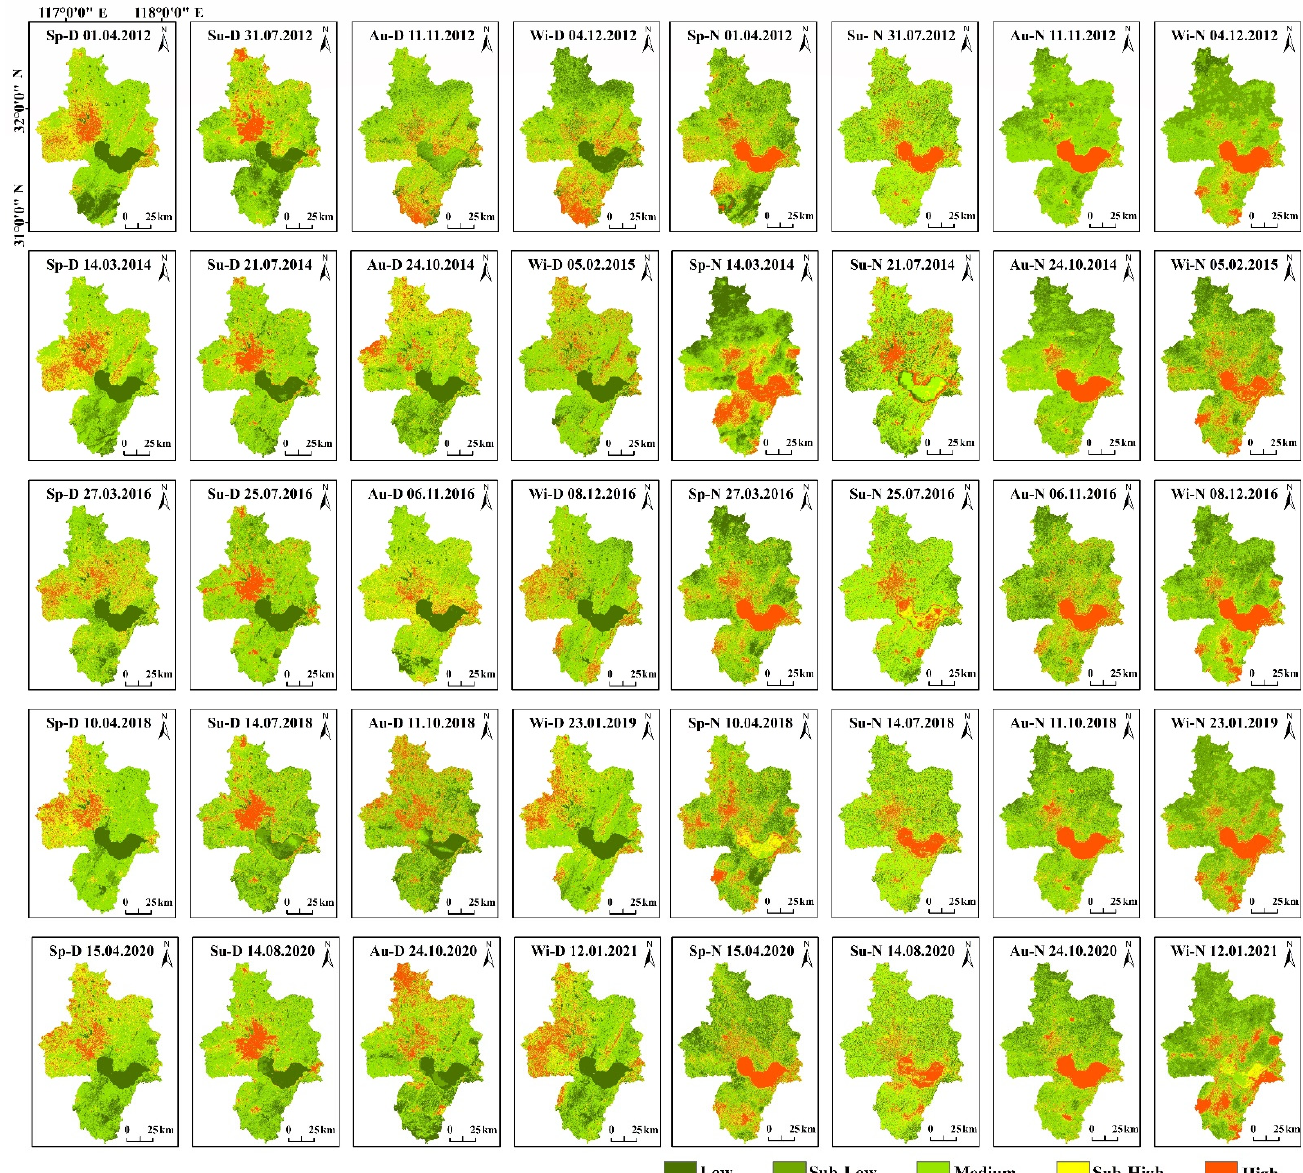
Figure 3. The images of SUHI in different seasons during day and night from 2011 to 2020 (D: day; N: night. Sp, Su, Au, and Wi represent spring, summer, autumn, and winter, respectively. Owing to the length of the article and the mapping effect, the images of SUHI are selected every two years, and those presented here are from 2012, 2014, 2016, 2018, and 2020).